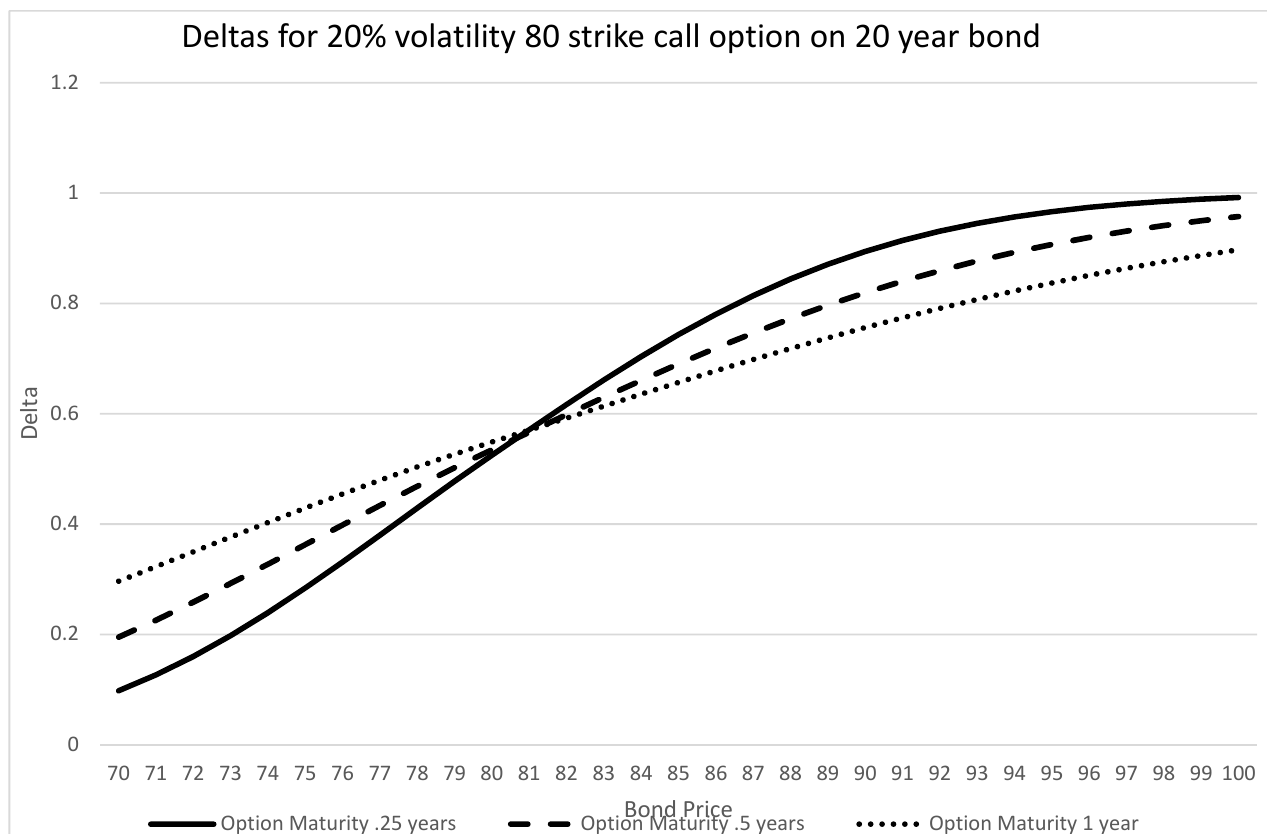
Figure 1. PTP deltas at different option maturities.